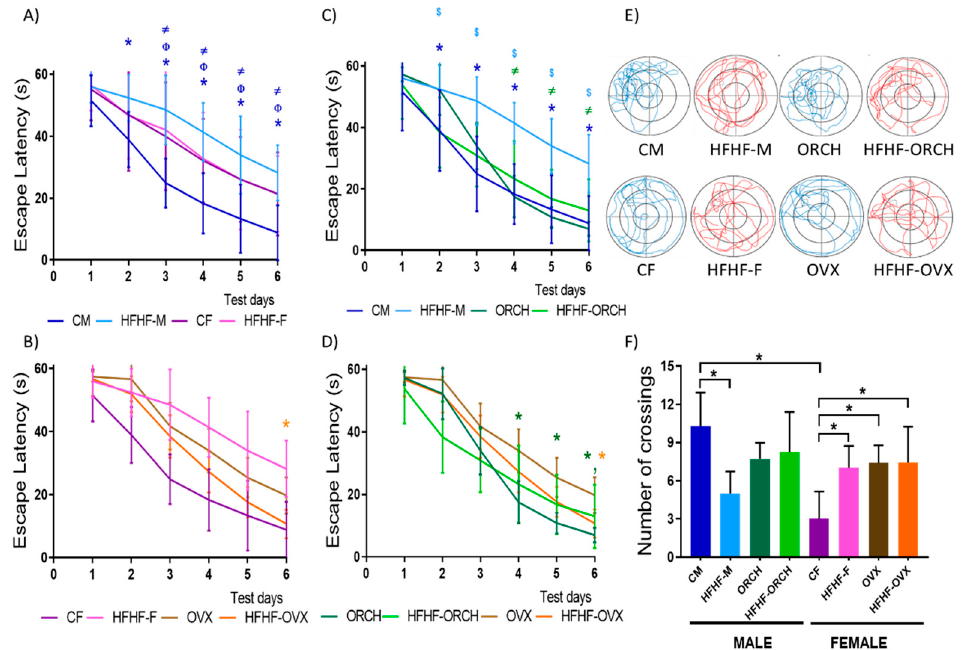
Figure 3. Effect of the HFHF diet in the tests of spatial learning and memory. ( A ) Escape latency in males: non-orchiectomized fed with standard diet, orchiectomized fed with standard diet, non-orchiectomized fed with standard diet, and orchiectomized fed with HFHF diet. The HFHF-M group presented a greater escape latency compared to CM, ORCH, and HFHF-ORCH groups. ( B ) Escape latency in females: non-ovariectomized fed with standard diet, ovariectomized fed with standard diet, non-ovariectomized fed with standard diet, and ovariectomized fed with HFHF diet. The HFHF-OVX group presented a smaller escape latency compared to CF, OX, and HFHF-OVX groups. ( C ) Escape latency in males and females: non-gonadectomized fed with standard diet and non- gonadectomized fed with HFHF diet. The HFHF-M, CF, and HFHF-F groups had greater escape latency compared to CM animals. ( D ) Escape latency in males and females: gonadectomized fed with standard diet and gonadectomized fed with HFHF diet. HFHF-ORCH presented a greater es- cape latency than ORCH group and HFHF-OVX had a lower escape latency compared to OVX